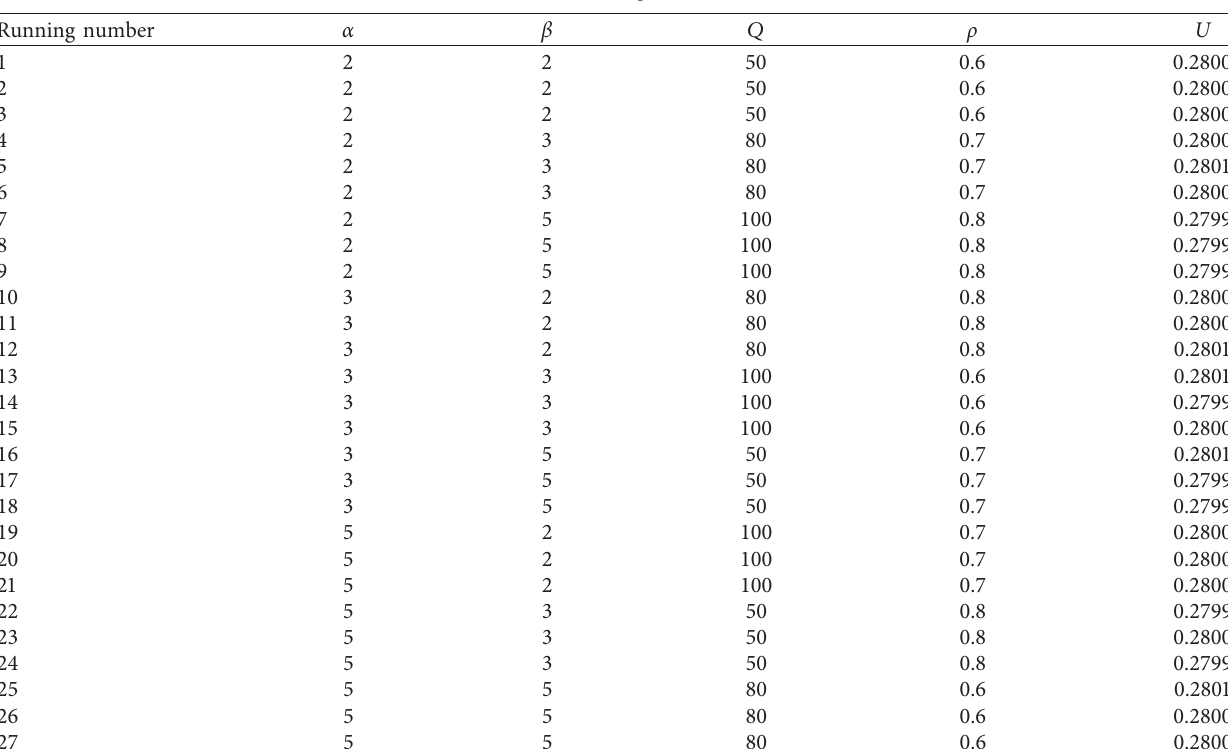
Table 12: The orthogonal test